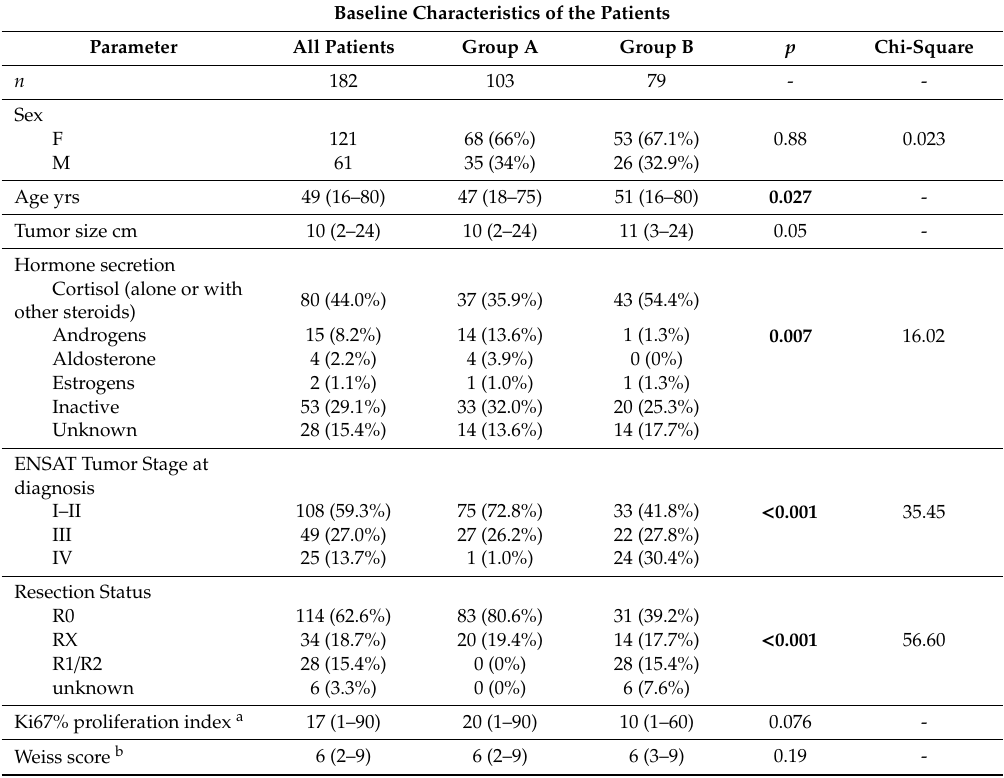
Table 1. Baseline clinical and histopathological characteristics of the entire cohort of patients with adrenocortical carcinoma and in group A and